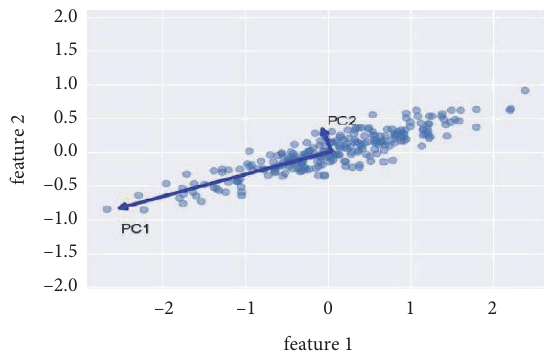
Figure 5: Illustration of the principal component